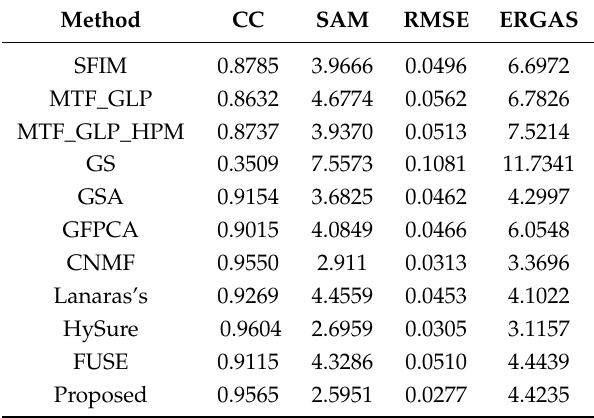
Table 5. Objective performance of eleven methods on the Chikusei data